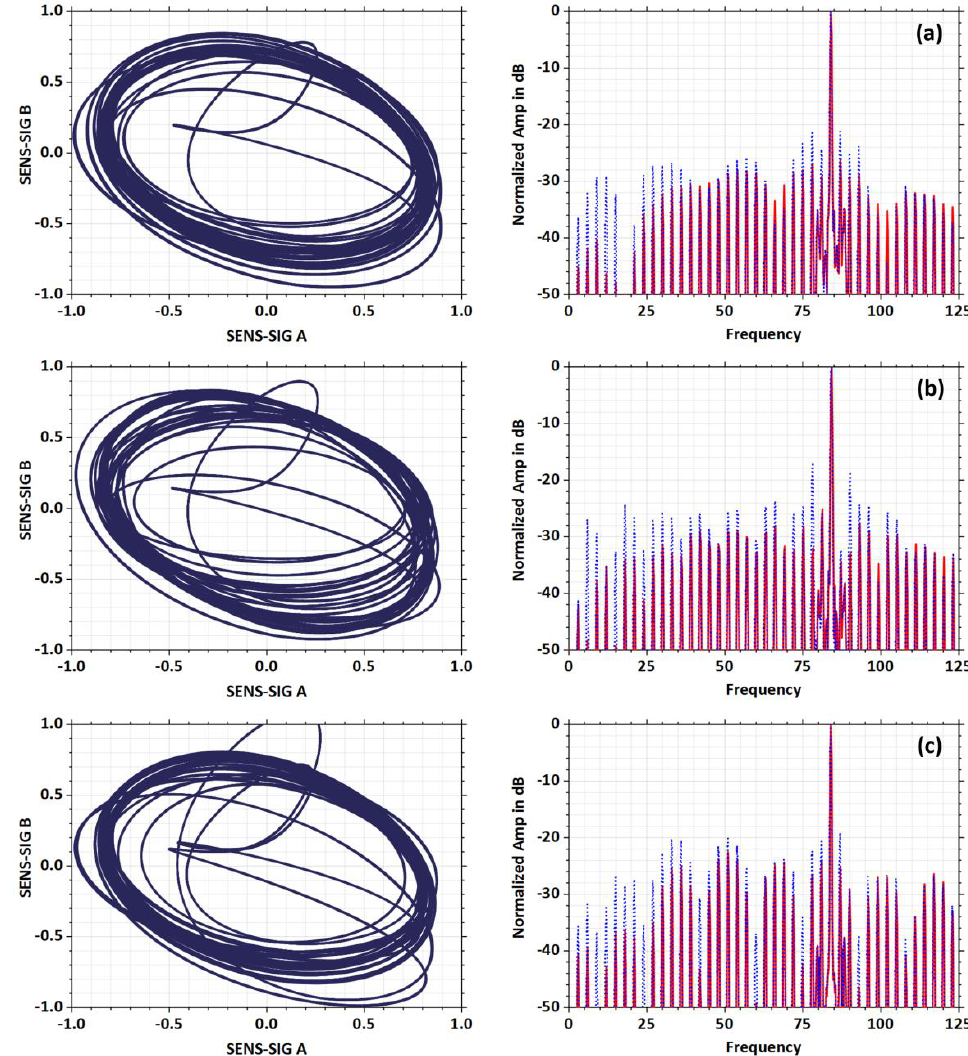
Figure 23. Comparison of FFT and oval patterns for combined rotor failures: ( a ) 1 broken bar + 1 broken end-ring segment; ( b ) 1 broken bar + 2 broken end-ring segments; ( c ) 2 broken bars + 1 broken end-ring segment.